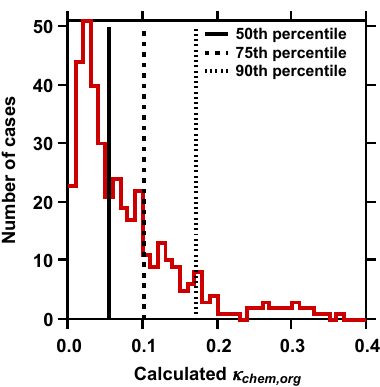
Figure 6. Histogram of results from a Monte Carlo analysis show- ing values of the organic κ chem that, given the observed inorganic composition and size distribution, are consistent within experimen- tal uncertainty with the measured f (RH). Vertical lines indicate the 50th, 75th, and 90th percentile values of the